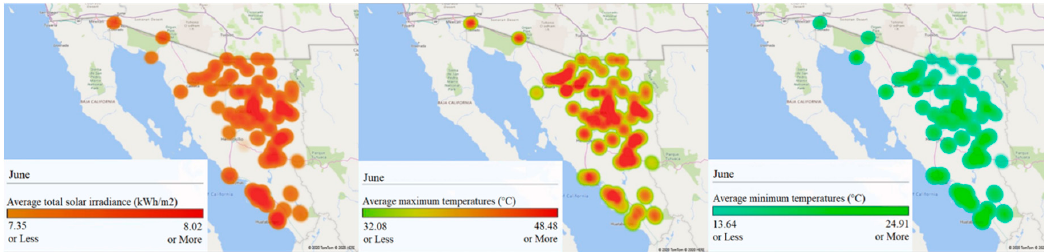
Figure 11. GIS analysis of Sonora for May: ( left ) average total solar irradiance (kWh/m 2 ), ( center ) maximum average temperatures (°C), and ( right ) minimum average temperatures (°C).